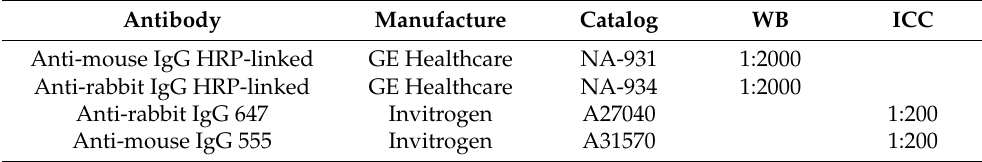
Table 3. Secondary antibodies used in this